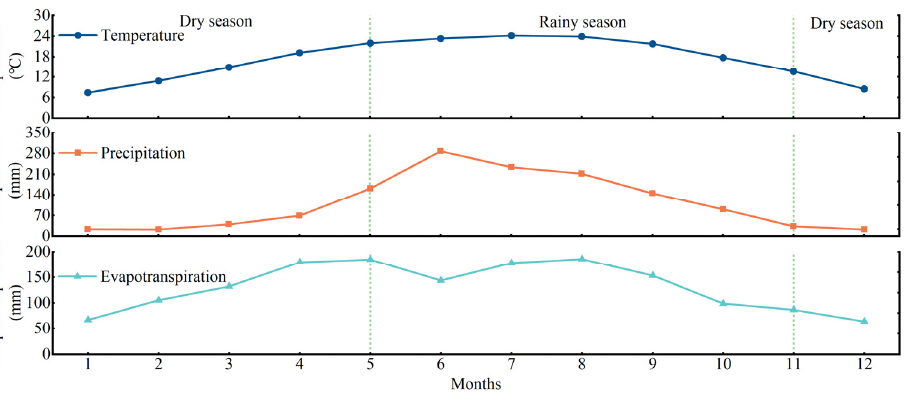
Figure 2. Monthly average variation of temperature, precipitation and evapotranspiration of Huajiang dry ‐ hot valley from 2002 to 2021.